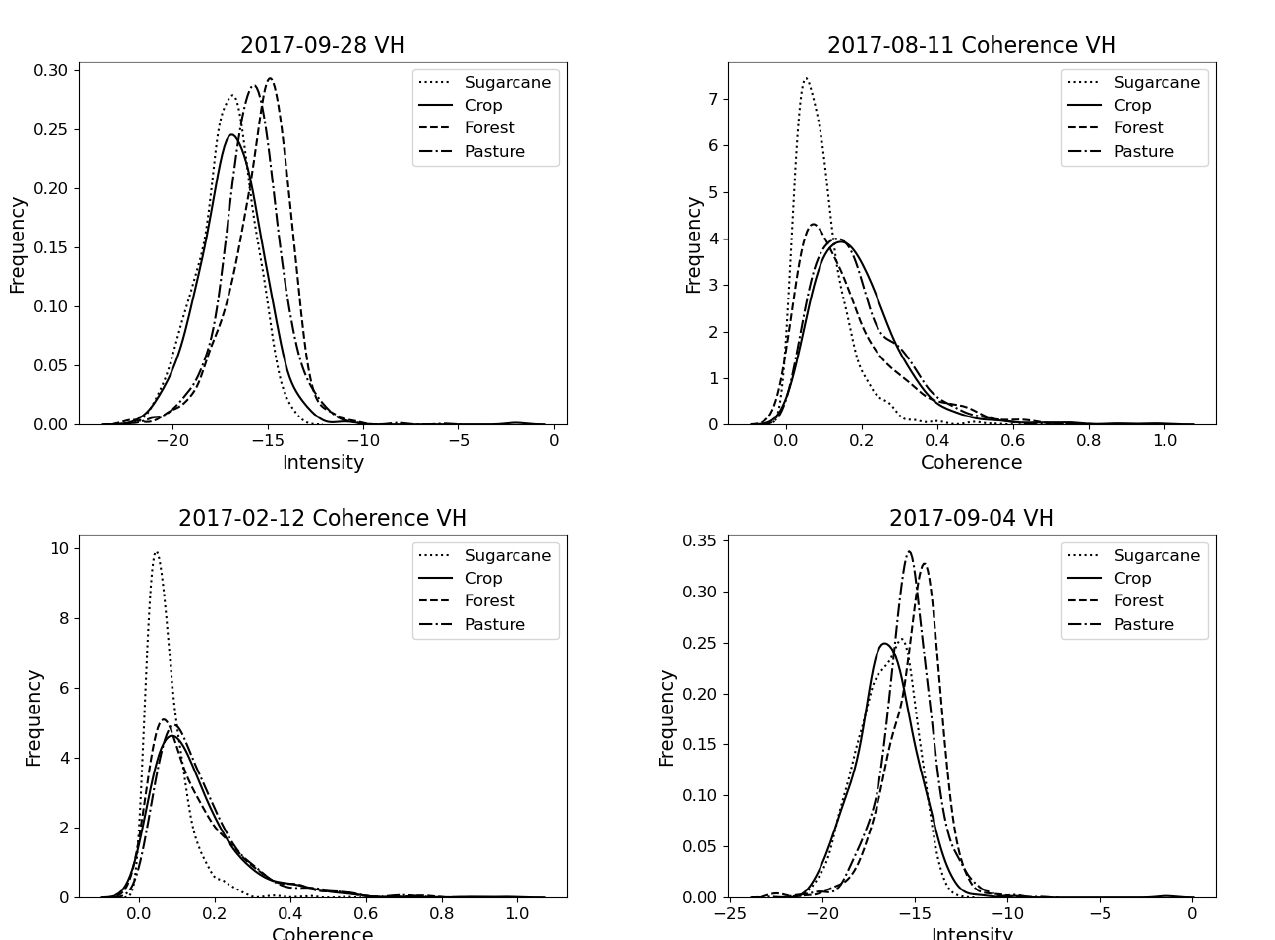
Figure 13. Histograms of the vegetated classes for the four most relevant features, as can be seen in Table 3, as selected by the mRMR